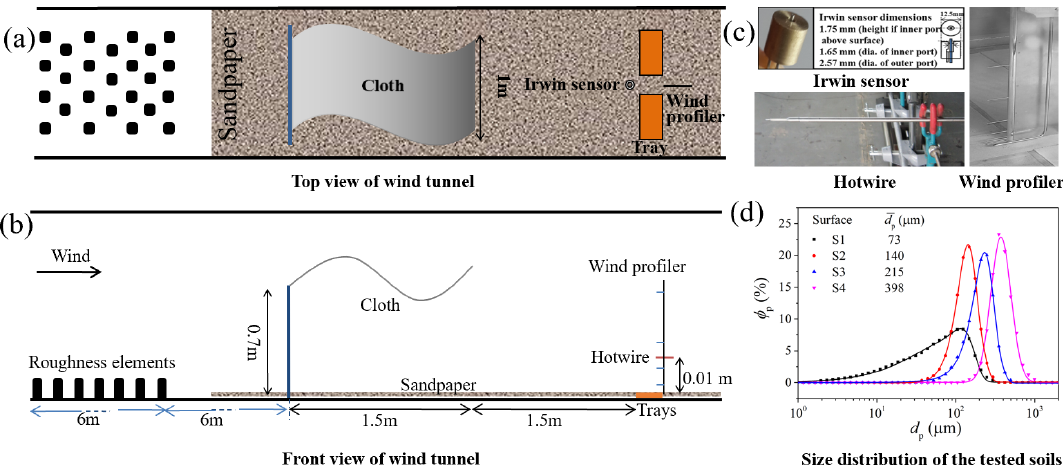
Figure 1. (a) Top view of the wind-tunnel configuration. (b) Side view of the wind-tunnel configuration, where a piece of randomly fluttering cloth generates quasi-convective turbulence. (c) The probes employed. The Irwin sensor has a diameter of 12.5mm. Its inner port has a diameter of 1.65mm and a height of 1.75mm, and its outer port diameter is 2.57mm. (d) The size distributions of four tested soils, where φ p is the volume fraction, and d p is the particle diameter. Table 1. Summary of wind-tunnel experiments. Fan speed ( × 100rpm) Repetitions